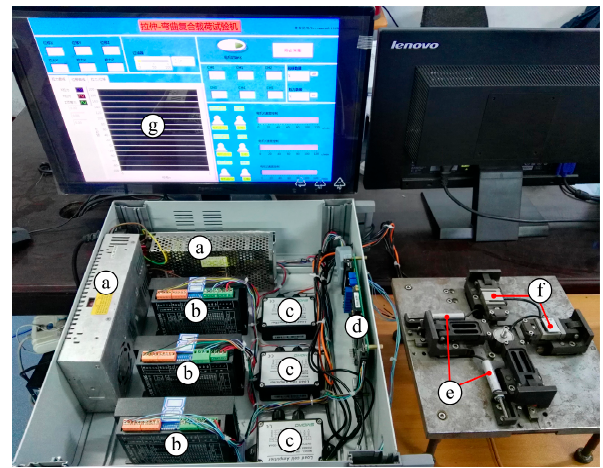
Figure 5. Loading test system diagram. ○ a Power supply; ○ b Motor control; ○ c Signal amplifier; ○ d Data acquisition card; ○ e Displacement transducer; ○ f Force transducer; ○ g Upper computer.